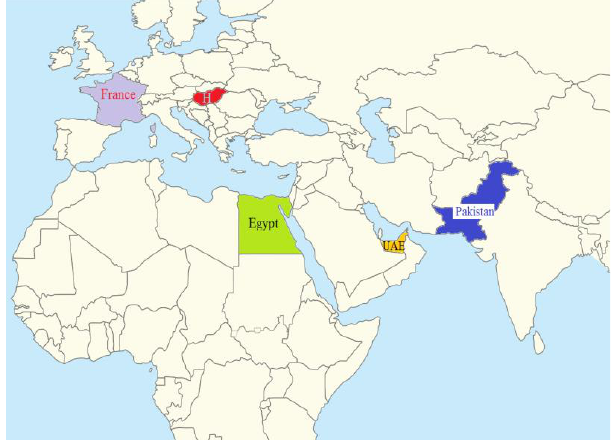
Figure 2: The geographic map showing the locations of the countries that the identified species are recorded in the Northern Tethys (France, Hungary) and Southern Tethys (Egypt, UAE, Pakistan)